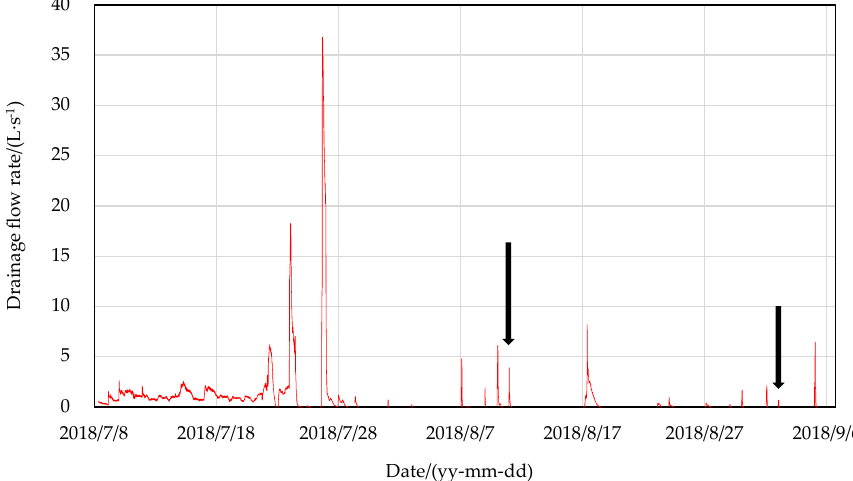
Figure 2. Drainage process of the field ditch from 8 July to 7 September 2018. The black arrows denote the time of insecticide applications.